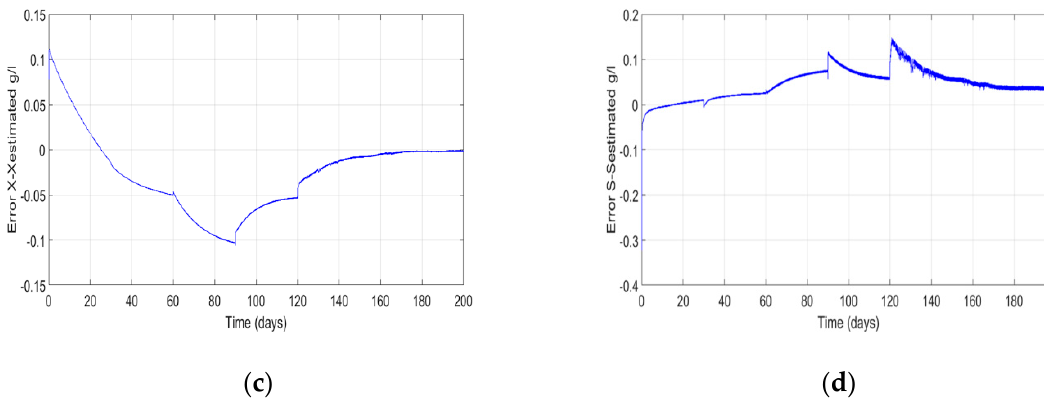
Figure 7. Anaerobic digestion sliding mode observer with PD based surface under a synergetic controller. ( a) Biogas flow rate evolution; ( b ) control signal; ( c ) error of the concentration of the bacterial population X ; ( d ) error of the concentration of the substrate S .